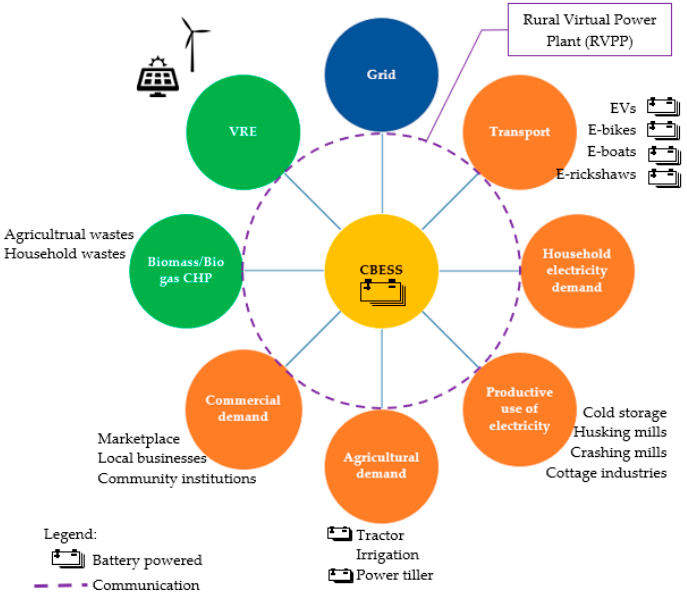
Figure 20. Concept of smart energy systems in rural areas considering the BSCS / CBESS as a central component.